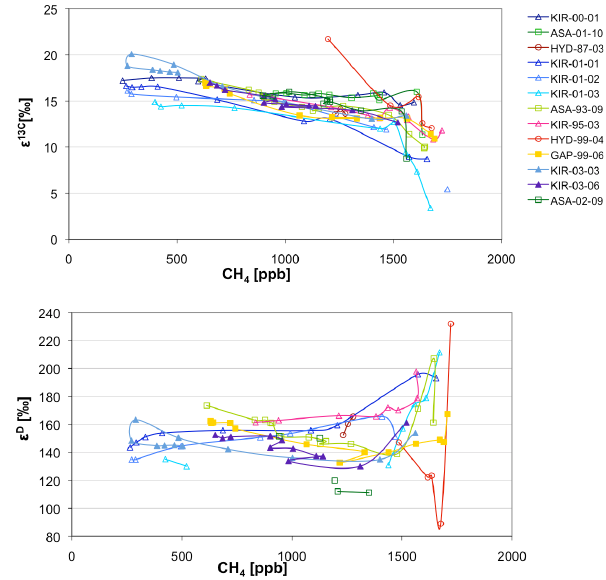
Figure 11: The bottom-up profiles show the increase in ε 13C with decreasing c min , which illustrates the decreasing importance of OH with increasing altitude (decreasing mixing ratio) and reduction of δ D relative to δ 13 C in the vortex. Some data points that include only lower stratospheric samples have been left out in the graphs, since they reflect tropospheric variations. The last data point (on the left side) of each line corresponds to the KIE mean results of Table 5, but as exceptional samples have not been excluded here, they can slightly differ from the values given there. Typically the topmost sample has the lowest methane mixing ratio in a profile and therefore defines c min . The major exception is KIR-03-03 (light blue), which has a minimum in the vertical mixing ratio profile, so that instead of c min the mixing ratio of the topmost sample characterises the related mean fractionation